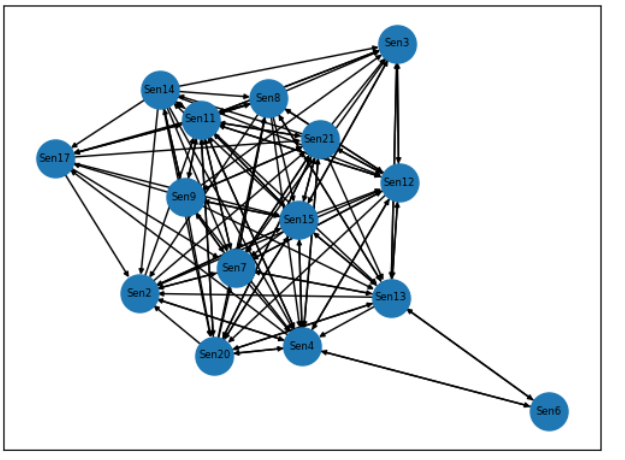
Figure 4. Statistical causal graphs of units in FD001 training set generated by the CGC